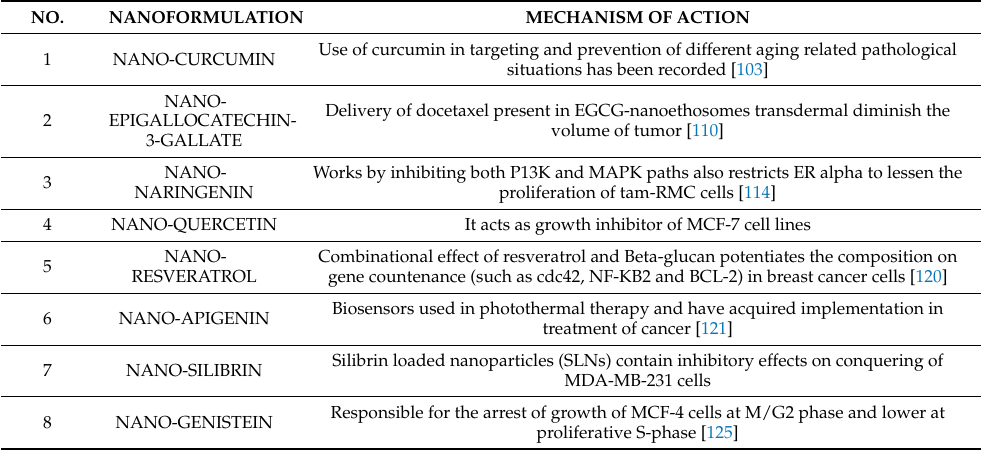
Table 2. Nanoformulations of flavonoids with mechanism of action in treatment breast